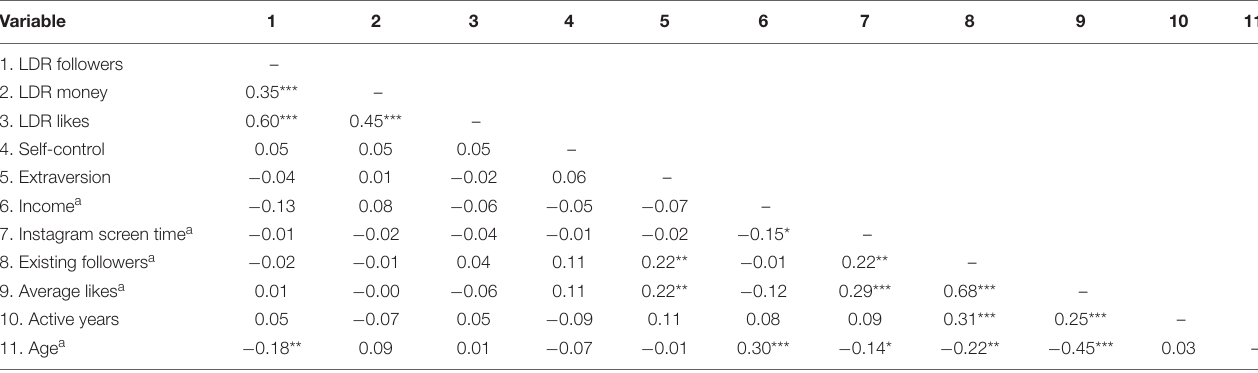
TABLE 1 | Correlations between main variables. Variable